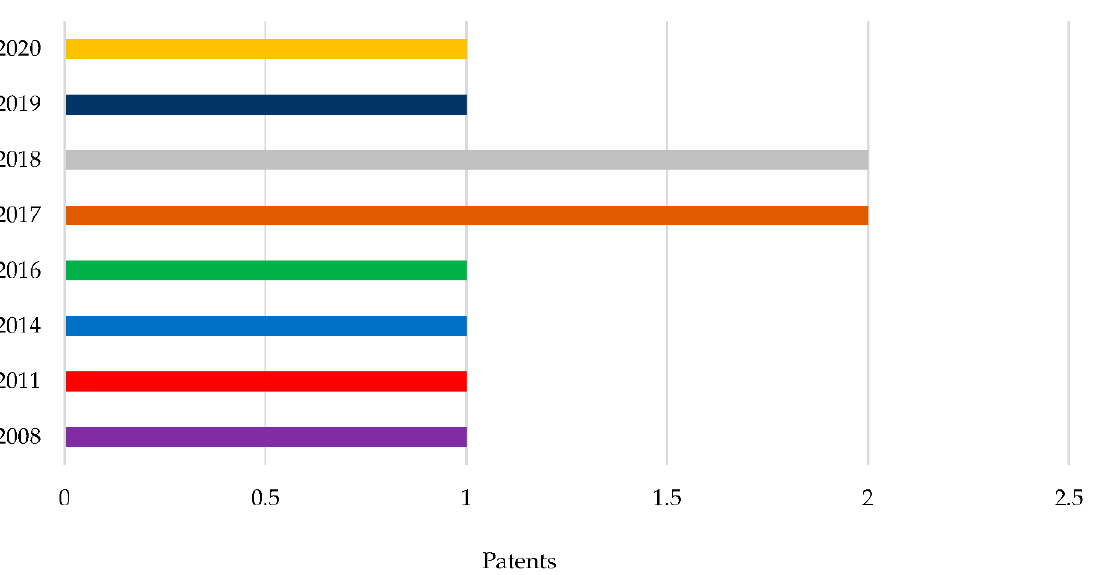
Table 9. Published studies using bacuri co-products ( Platonia insignis) in the development of food products.